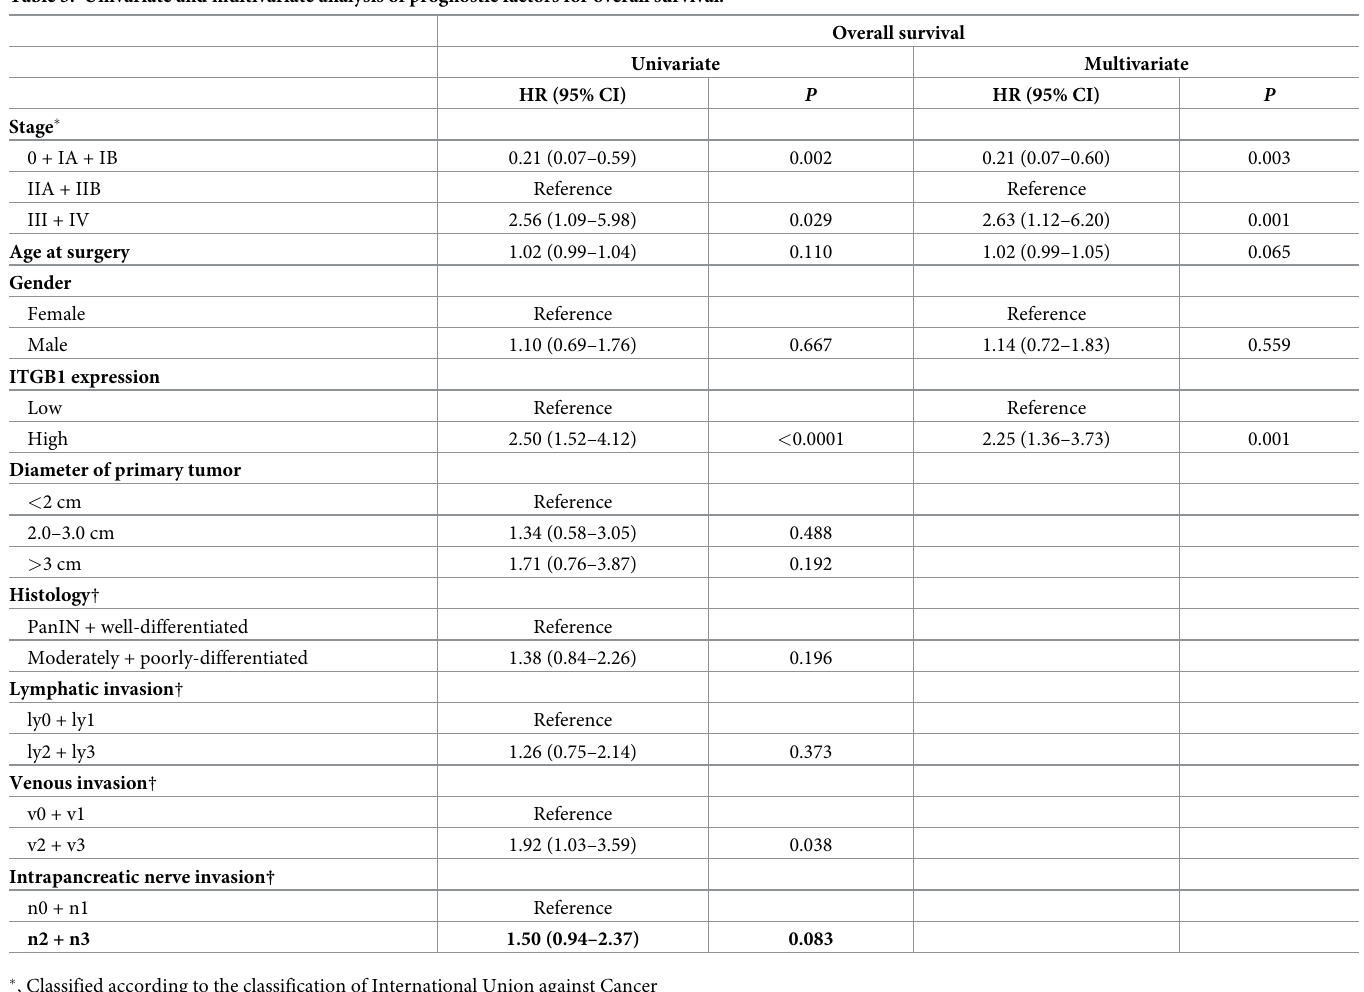
Table 3. Univariate and multivariate analysis of prognostic factors for overall